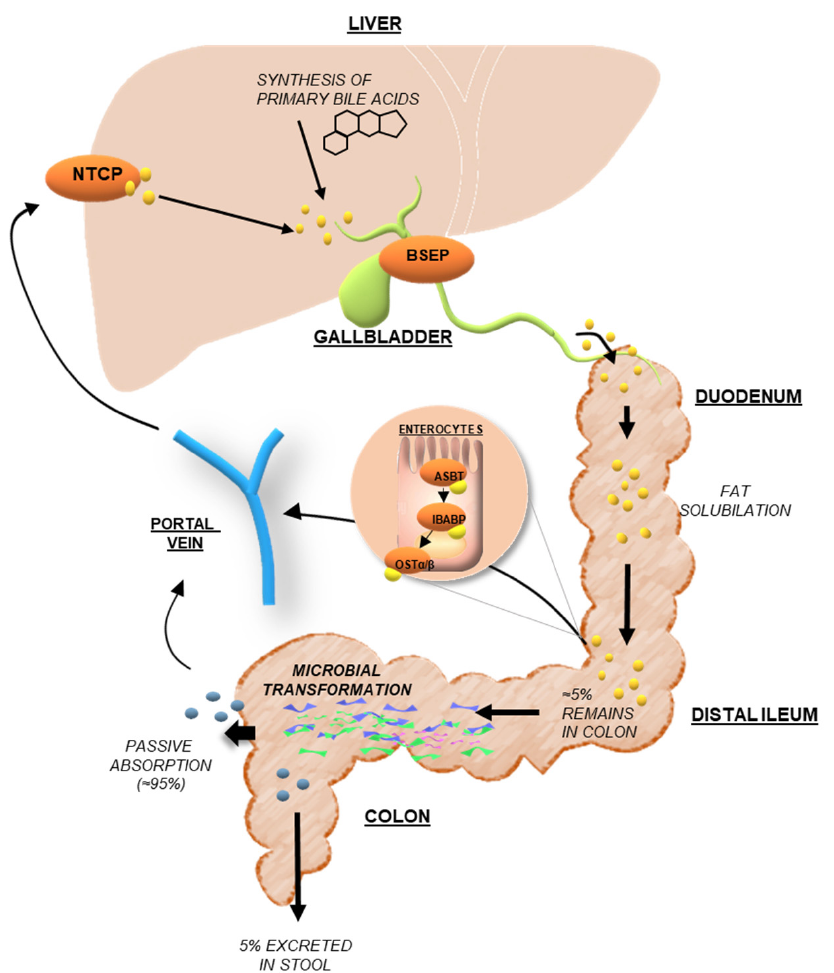
Figure 4. Representation of BAs enterohepatic circulation. After a meal, conjugated BAs are released from the gallbladder to the duodenum. When reaching the distal ileum, conjugated BAs are retrieved by ASBT at the luminal membrane, addressed to the basolateral membrane of the ileal enterocyte by the cytosolic transporter IBABP, and then released in the portal blood via the OST α / β transporter to come back to the liver and be taken up by the NTCP transporter and complete the enterohepatic circulation. Via the canalicular bile salt export pump (BSEP), BAs are then stored in the gallbladder as bile salts in the bile. Secondary unconjugated BAs are passively reabsorbed in the colon. The figure is original and created with